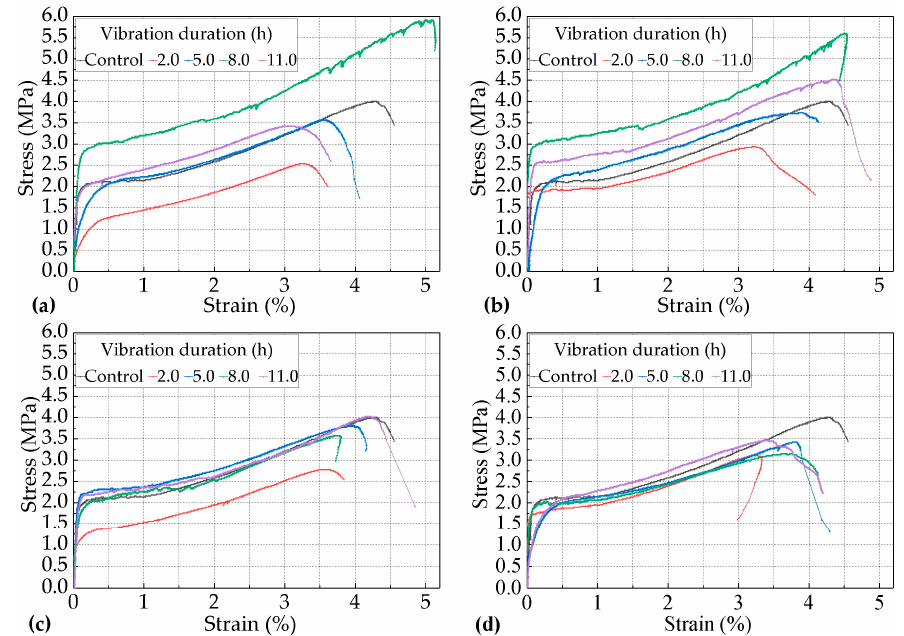
Figure 6. Strain-stress curves of the vibrated PVA-ECC groups subjected to different lengths of vibration duration under the combination of different levels of vibration frequency and the age of 8.0 h when vibrated and, ( a ) 2.0 Hz; ( b ) 3.0 Hz; ( c ) 4.0Hz; ( d ) 5.0 Hz.